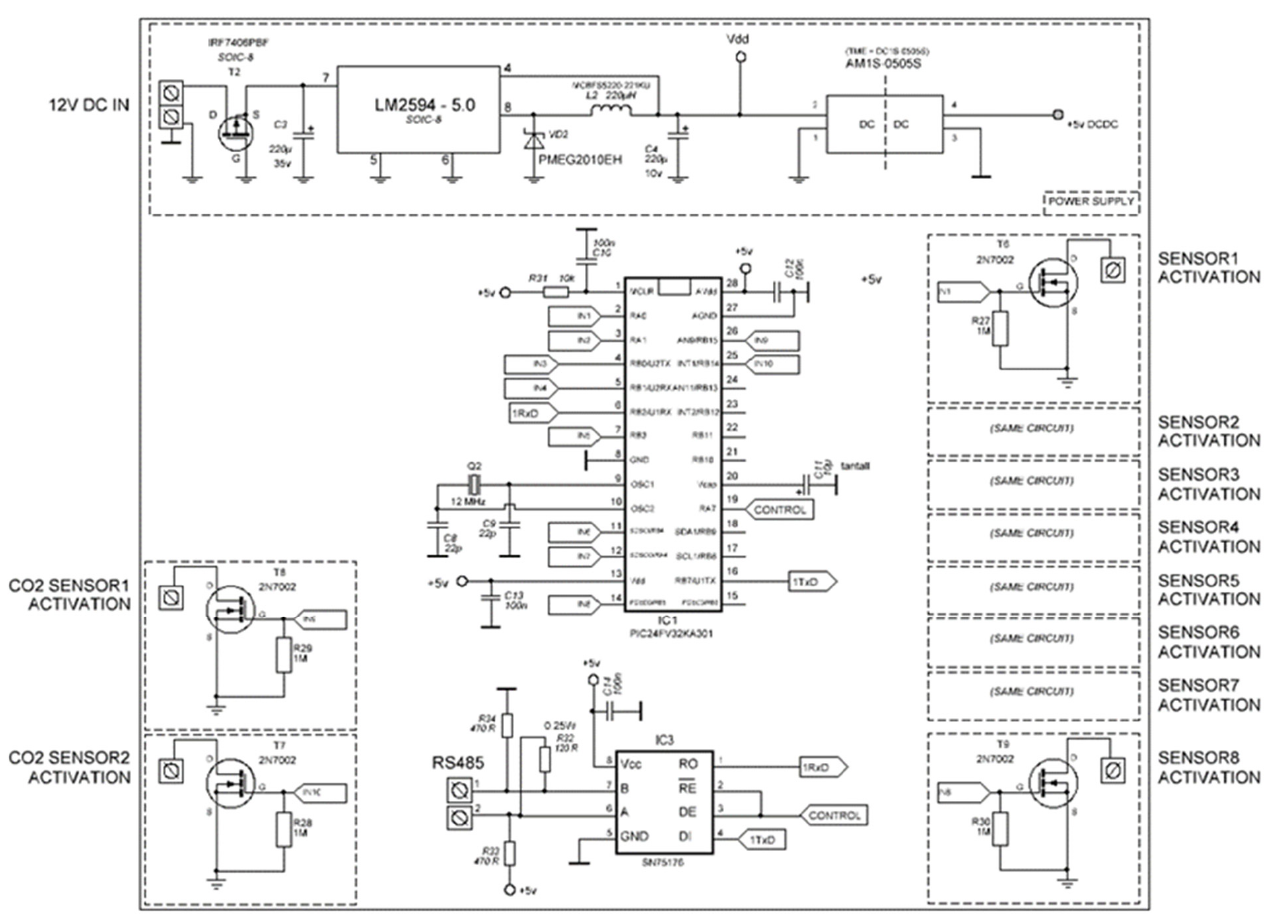
Figure 3. Main PLC communication power plant circuit.